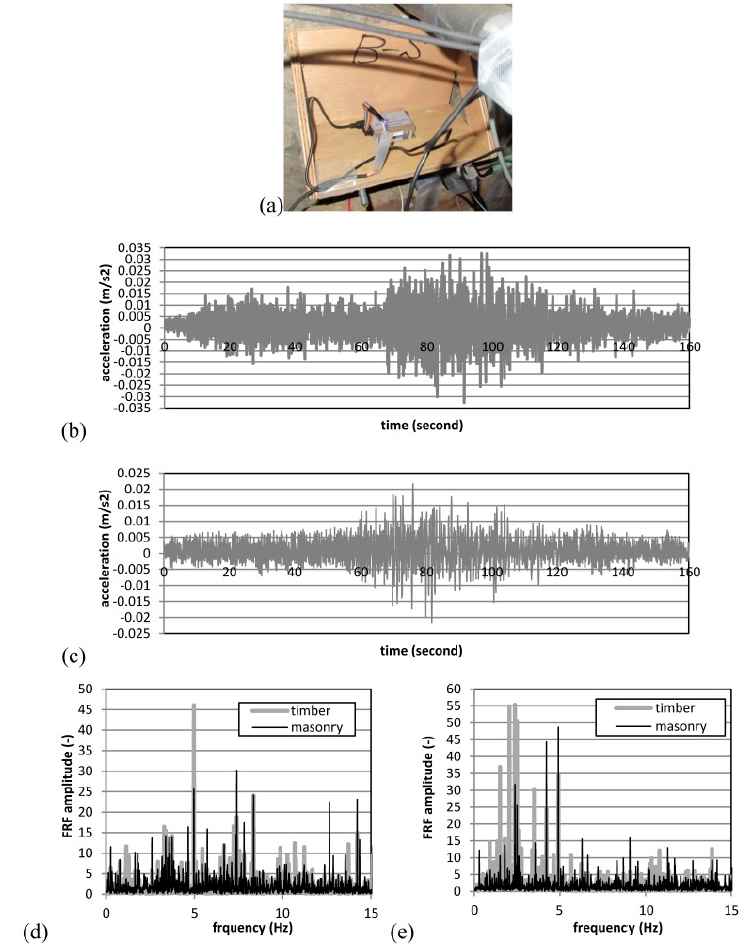
Figure 7. Monitoring of the Otaru warehouse: ( a ) Installed MEM sensor, acceleration time history of the HO1 sensor during the 2021 Fukushima earthquake ( b ) and during the May 2021 Miyagi earthquake ( c ), wall/stud to floor frequency response functions obtained from the 2021 Fukushima earthquake ( d ) and from the May 2021 Miyagi earthquake ( e ).